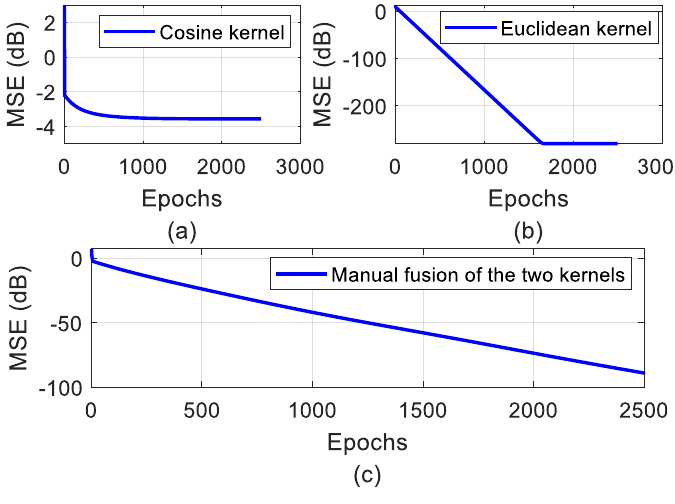
Figure 5. Mean Square Error curves of the training phase ( a ) Cosine Kernel, ( b ) Euclidean Kernel, ( c ) Manual fusion of Cosine and Euclidean Kernel.